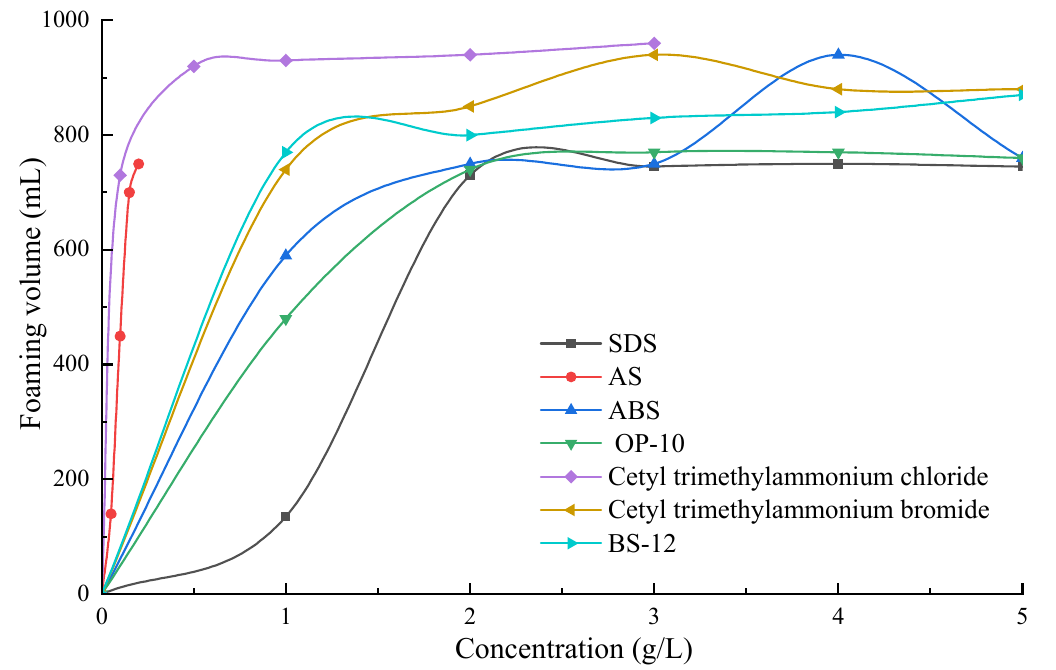
Figure 2. Foaming volume diagram of different surfactants.